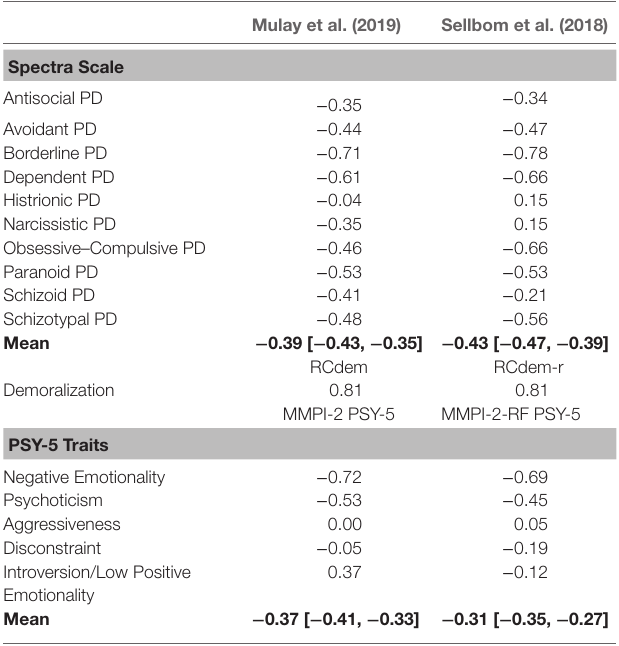
TABLE 2 | Correlations between SIPP-18 LPF Factor Scores and Mulay et al. (2019) and Sellbom et al. (2018) PD Spectra scales, Demoralization, and PSY-5 Maladaptive